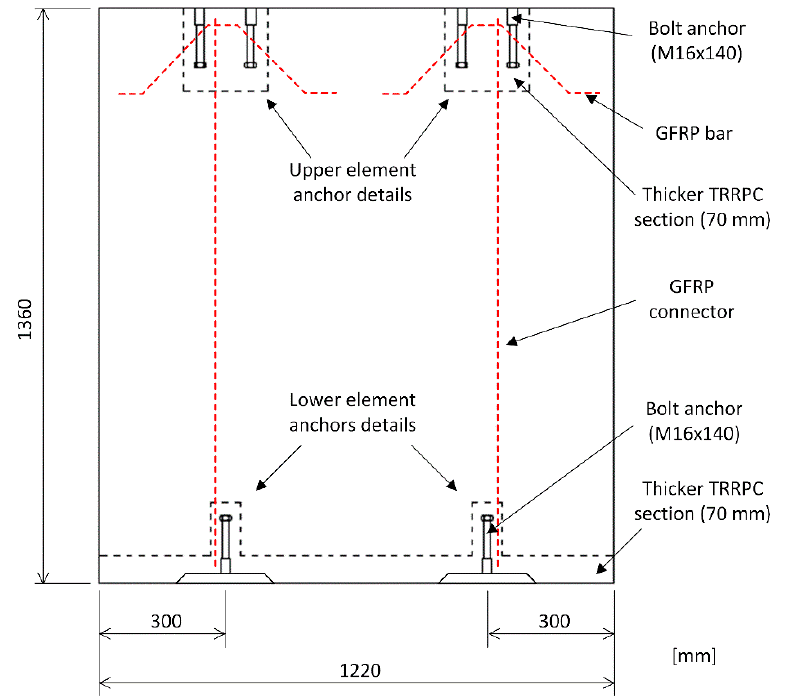
Figure 5. Illustration of the anchor tests specimens.